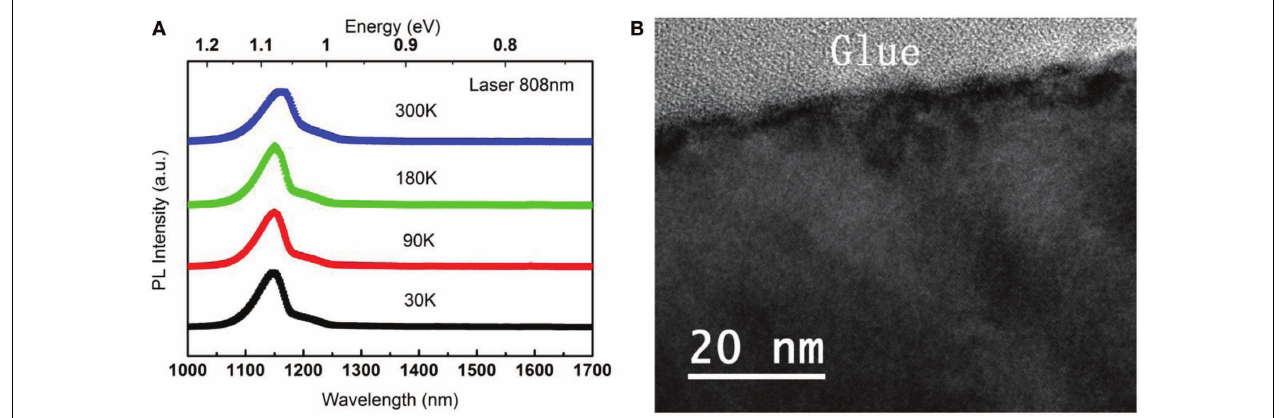
FIGURE 5 |The dependence of peak intensity of EL band at 0.78eV on the input power of pn-junction diodes .